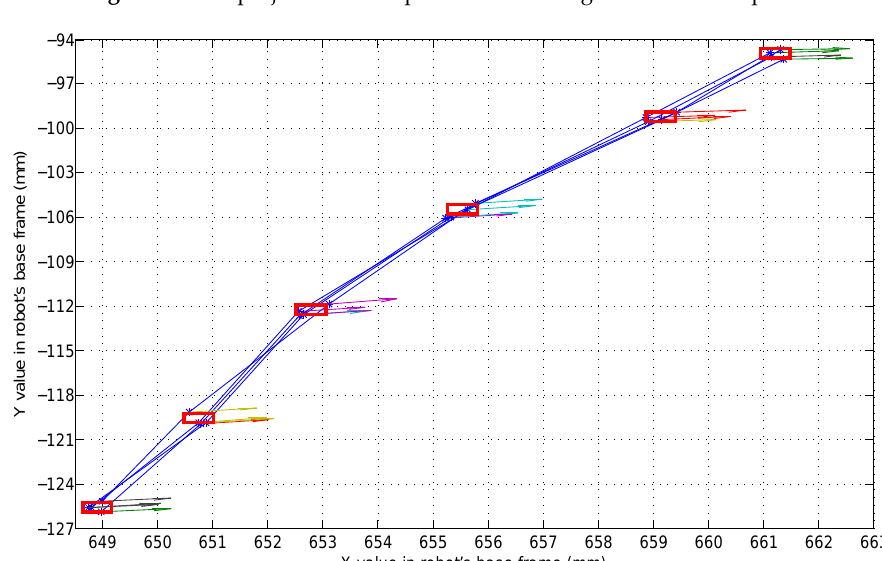
Figure 10. The projection of the paths shown in Figure 9 on the XY plane.